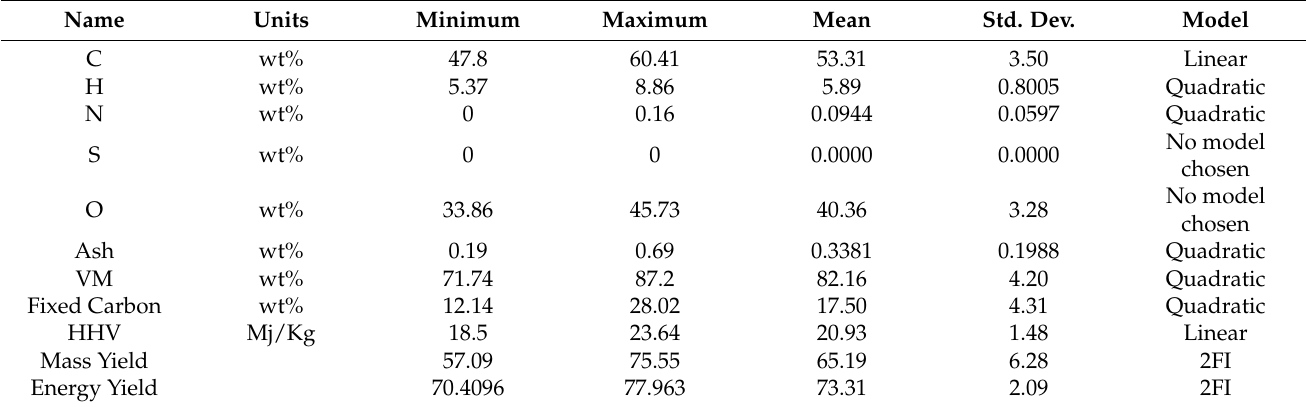
Table 5. Mean and Std. Dev of